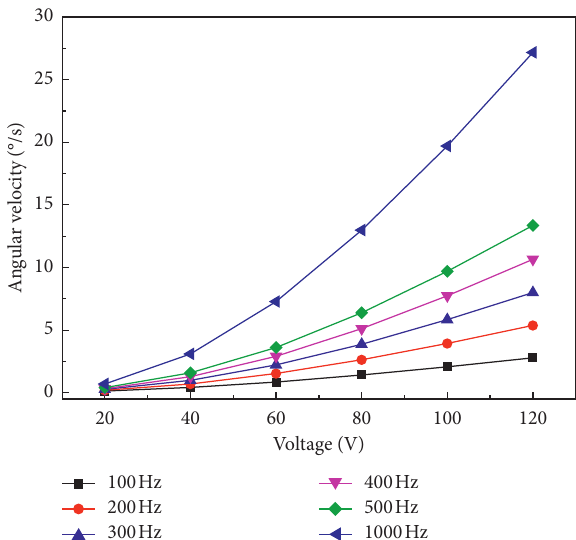
Figure 9: Simulation results of the PA’s angular velocity under different frequencies and amplitudes of sawtooth waveform.